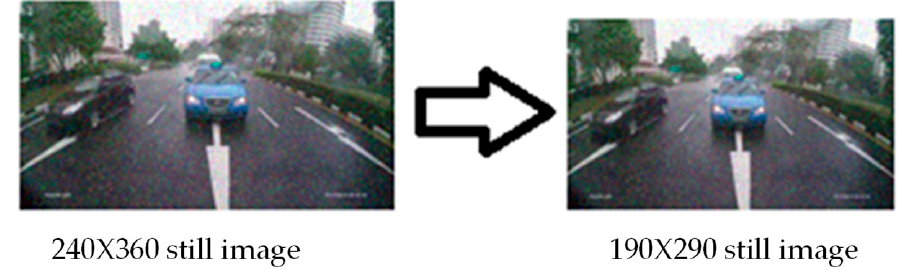
Figure 3. Image Figure 3. Image resizing.